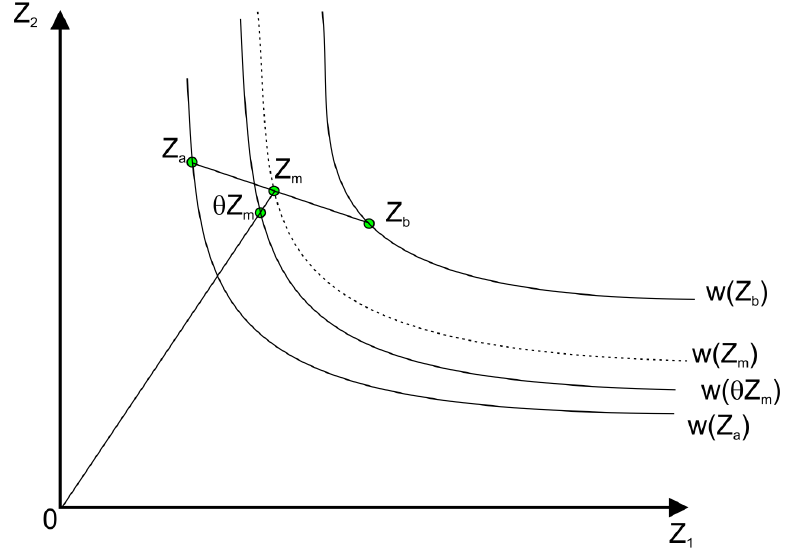
Figure 1: The equally distributed equivalent amount of